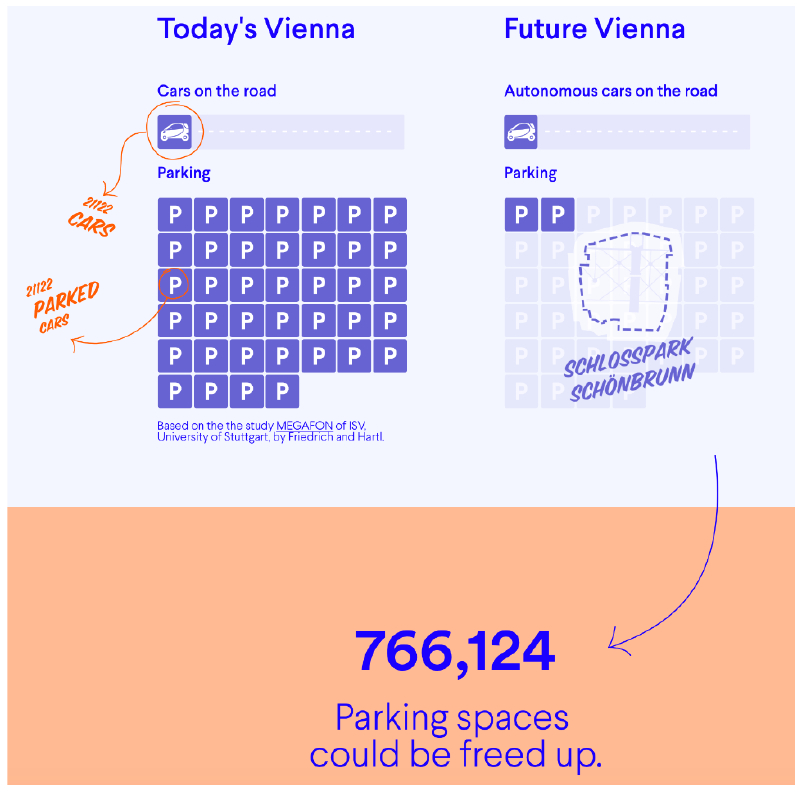
Figure 7. The spatial consequences of a scenario in which all cars in a city are replaced by an autonomous, shared fleet of